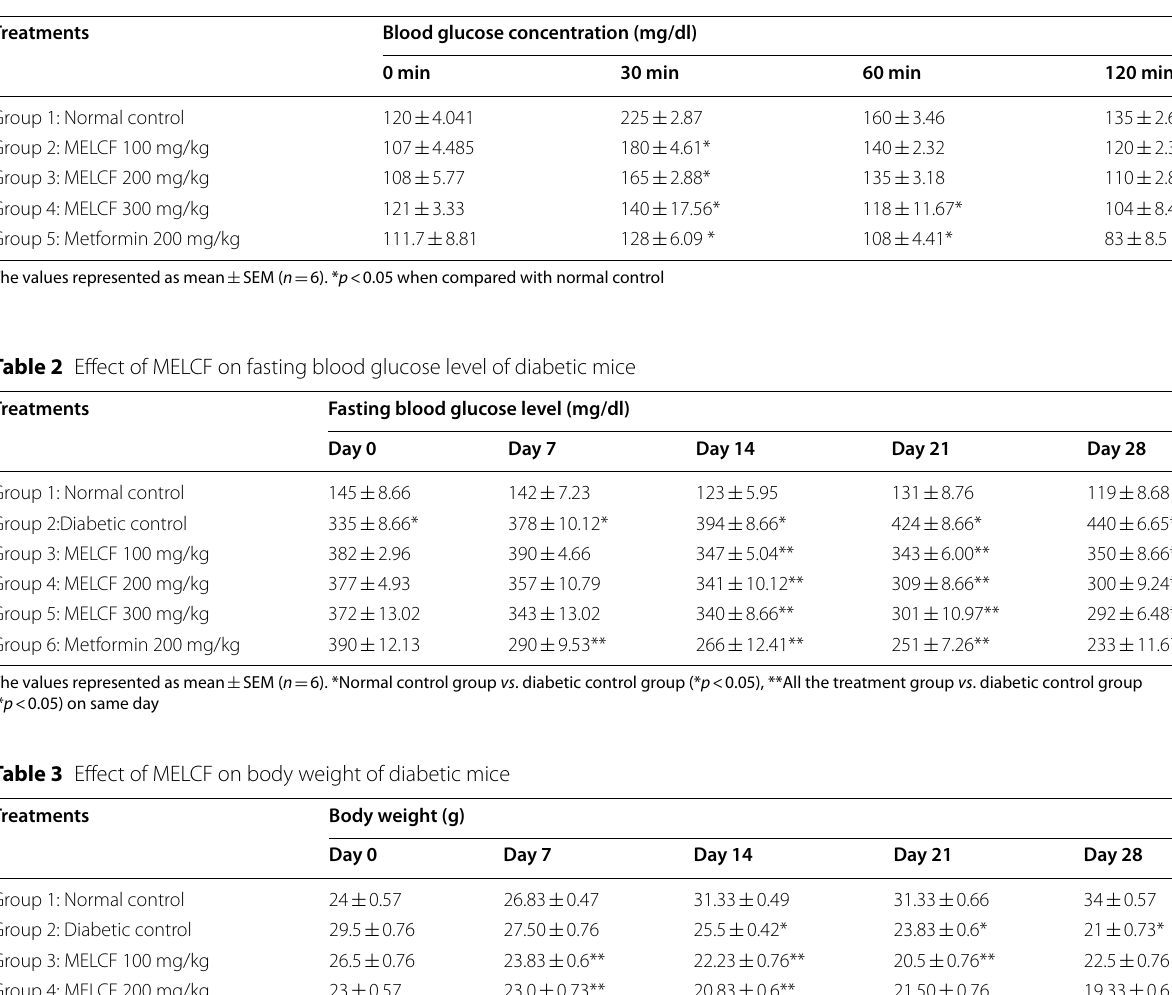
Table 1 Effect of MELCF on OGTT in mice Treatments